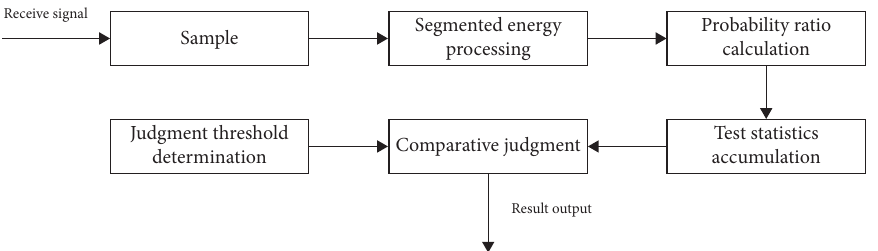
Figure 1: Block diagram of piecewise linear discriminant algorithm